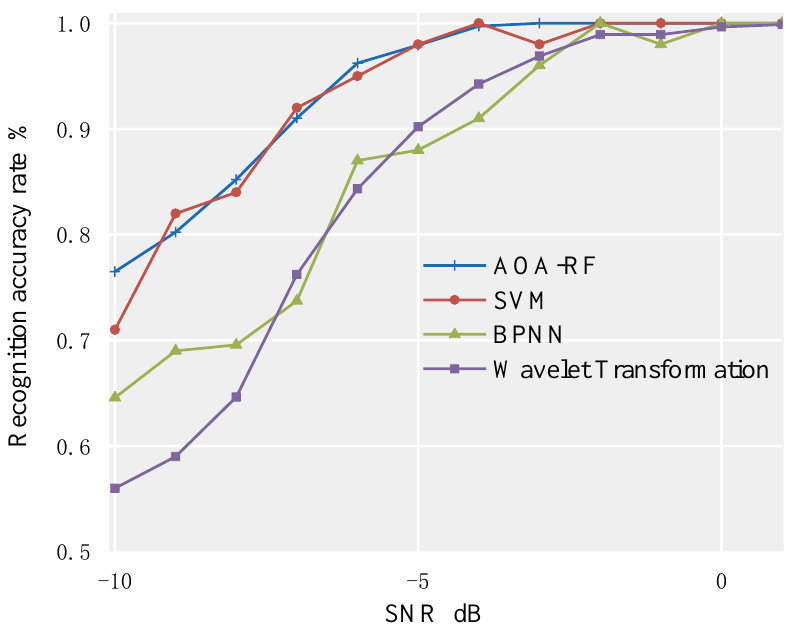
Figure 12. Comparison of average recognition rate between AOA–RF algorithm and new method. Table 3. Recognition accuracy of different methods under different SNR environments.